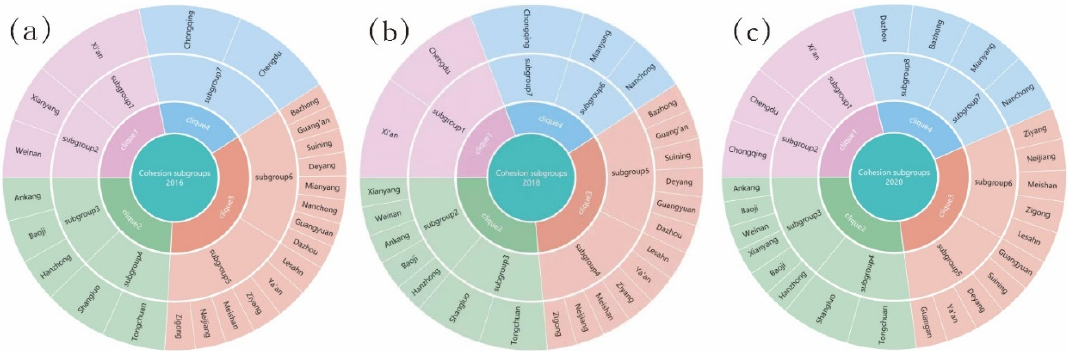
Figure 4. Cohesive subgroup structure of cultural tourism Internet attention in WTEZ: ( a ) 2016; ( b ) 2018; ( c ) 2020.